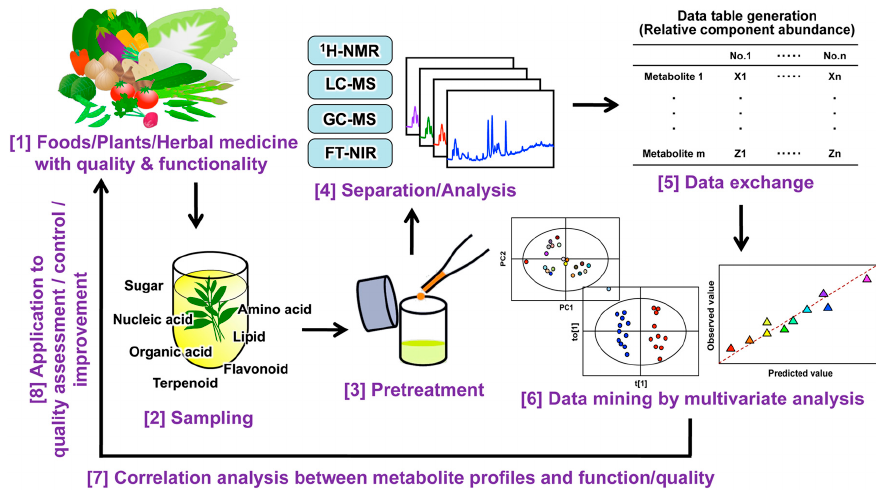
Figure 3. Process flow for a typical metabolic profiling experiment.